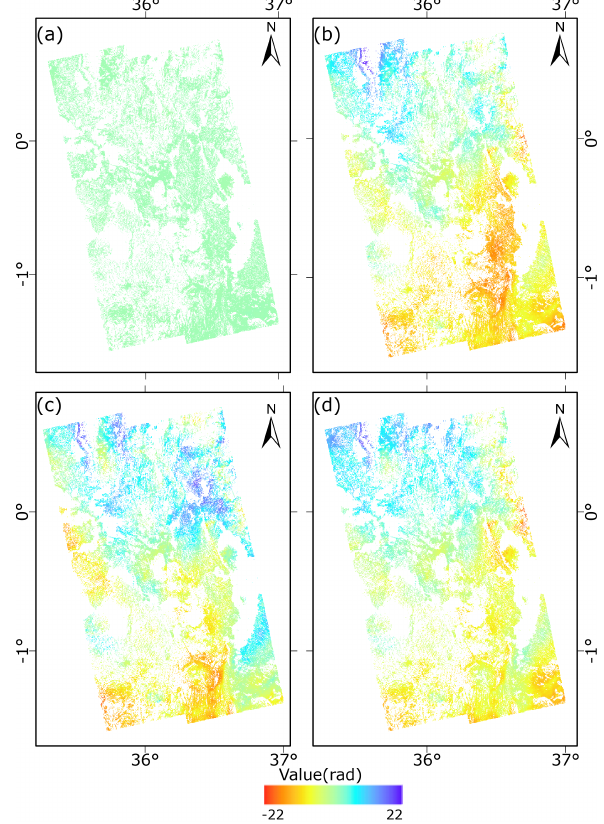
Figure 6. Example of a corrected interferogram (20190801-20190813) with different correction methods. In (a), the tropospheric delay is corrected using SAR-based estimates, whereas in (b), (c), and (d), corrections are performed using ERA-5, MERRA-2, and GACOS tropospheric delay estimates, respectively.